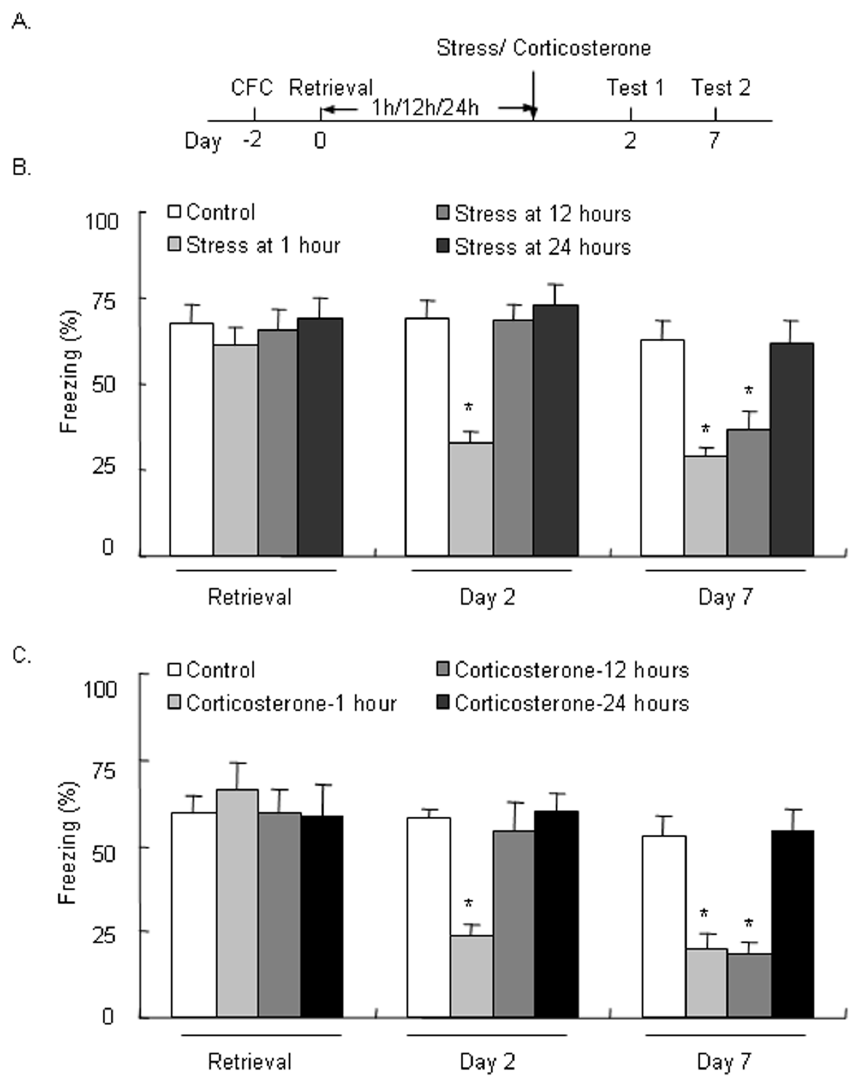
Figure 3. Stress and corticosterone administered 12 h after fear memory retrieval selectively impaired the persistence but not formation of long-term memory. (A) Rats were exposed to cold water stress or administered corticosterone 1, 12, or 24 h after retrieval of the memory of strong contextual fear conditioning (CFC) and then tested for long-term memory (LTM) on day 2 and day 7. (B) Stress exposure 1 h after CFC retrieval enhanced LTM reformation tested on day 2, whereas stress exposure 12 h after CFC retrieval selectively enhanced the persistence of LTM tested on day 7 but did not affect LTM reformation tested on day 2. (C) Corticosterone administration 1 h after CFC retrieval enhanced LTM formation tested on day 2, whereas corticosterone administration 12 h after CFC retrieval selectively enhanced the persistence of LTM tested on